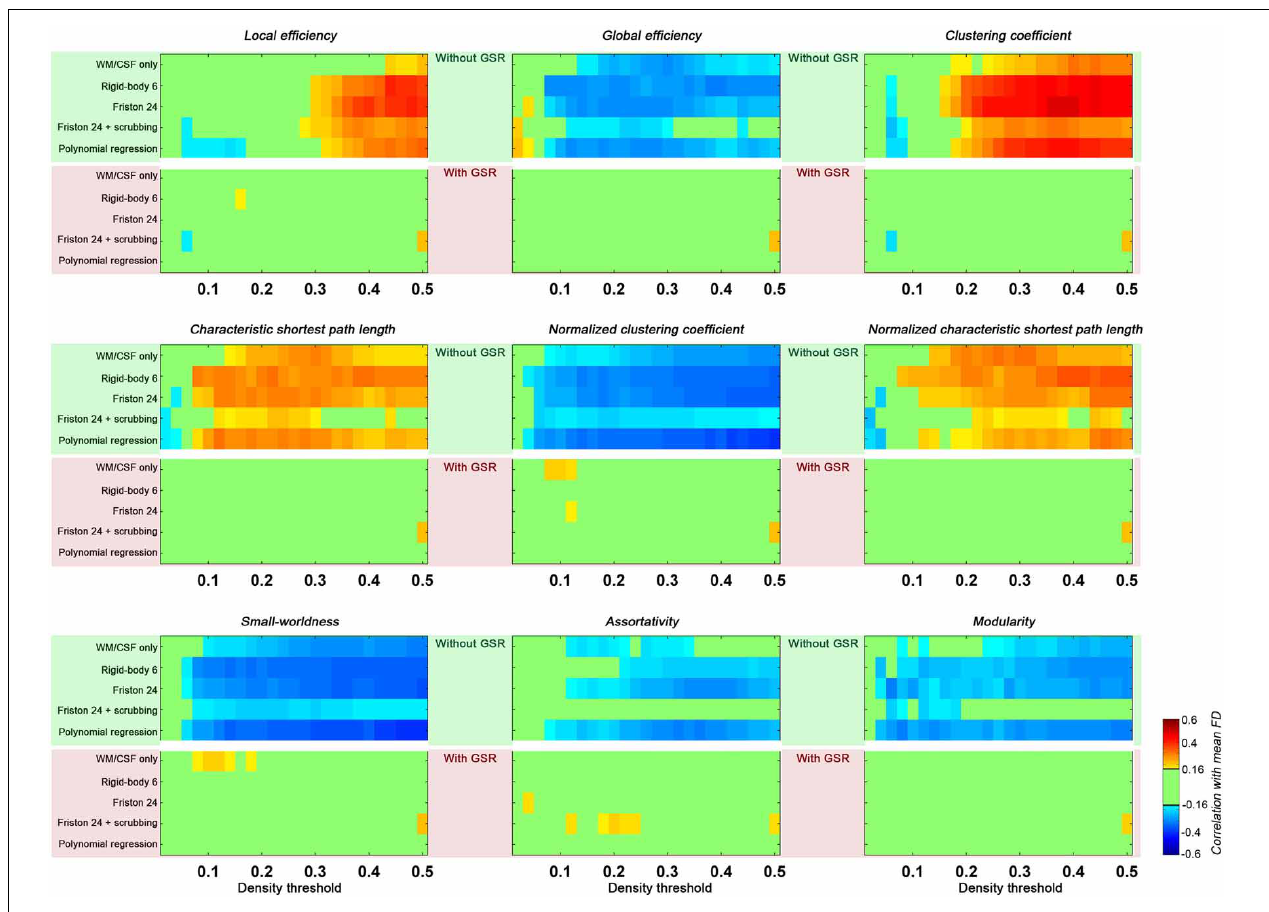
FIGURE 4 | Correlations between head motion and global topological properties. Each panel presents one property. The upper green shaded section is without GSR and the lower pink shaded section is with GSR. Each row represents a preprocessing